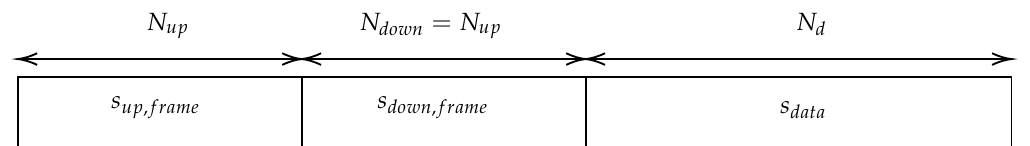
Figure 3. The modified self-jamming LoRa frame